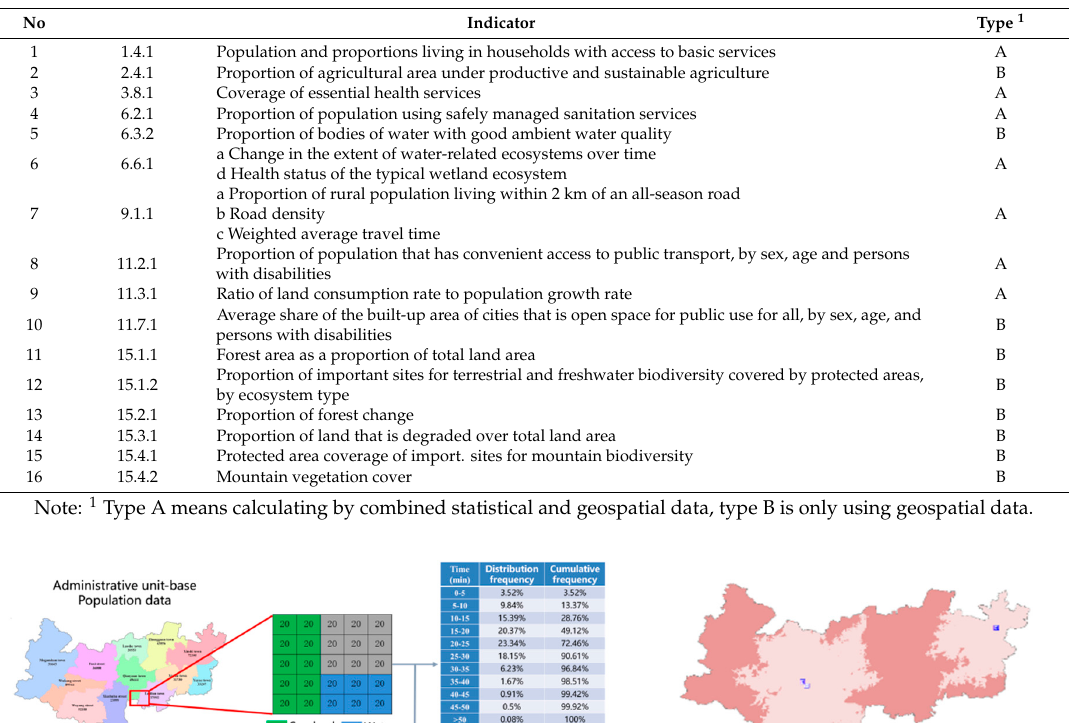
Table 2. The 16 indicators derived using geospatial data.